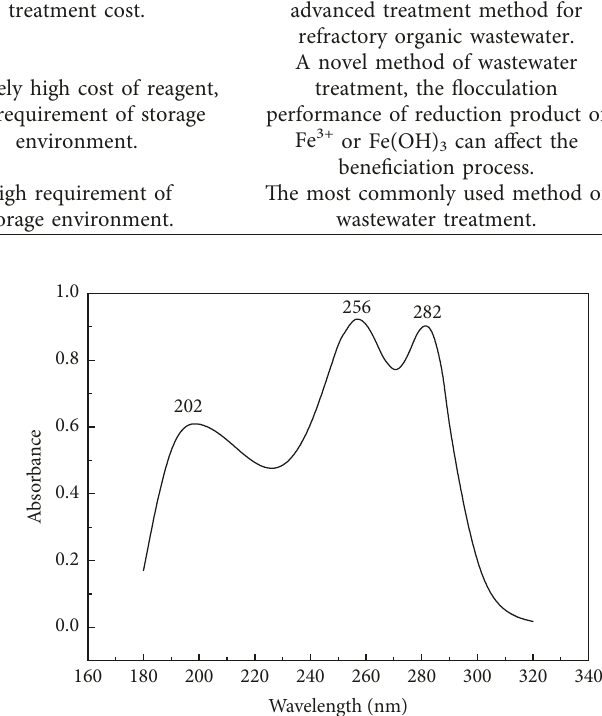
Figure 1: UV absorption spectrum of DDTC.